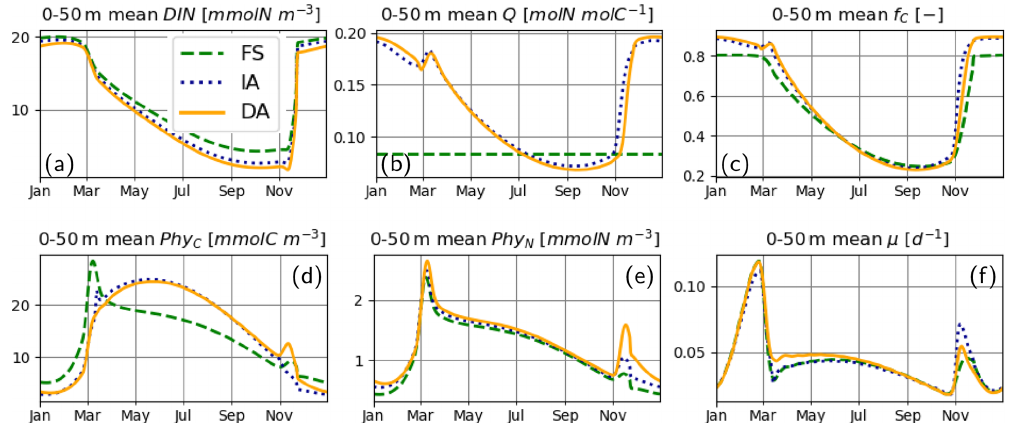
Figure B2. Like Fig. 7 but when, for the FS variant, prescribed ˆ θ (Table 3) is scaled with L N , i.e., replacing f C with L N in Eq. (24).